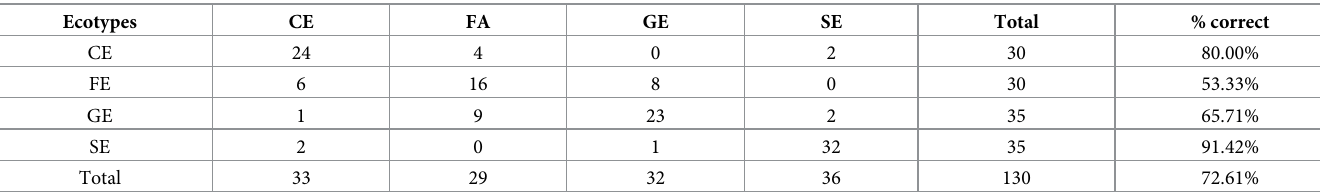
Table 6. Percentages of individual classification per state based on discriminant analysis.